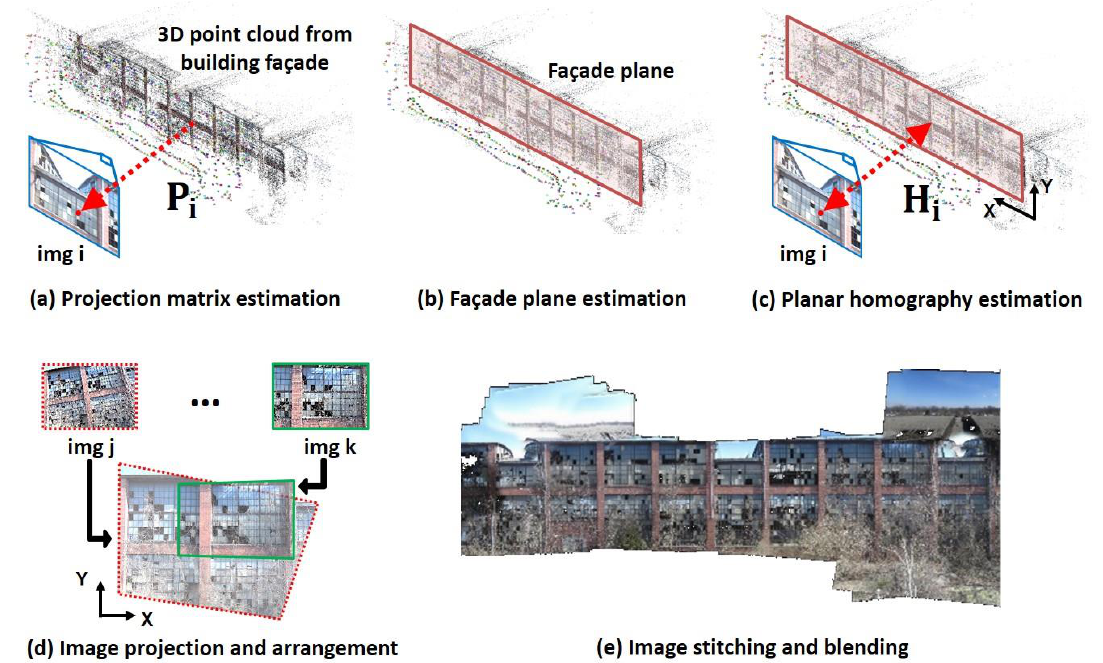
Figure 2. Overview of the orthophoto generation: ( a ) Projection matrix estimation for each image using structure-from-motion (SfM) technique, ( b ) Façade plane estimation from a 3D point cloud, ( c ) Planar homography estimation from corresponding projection matrix, ( d ) Image projection and arrangement into the estimated façade plane (parallel to the XY-plane), and ( e ) Image stitching and blending to generate the complete orthophoto.